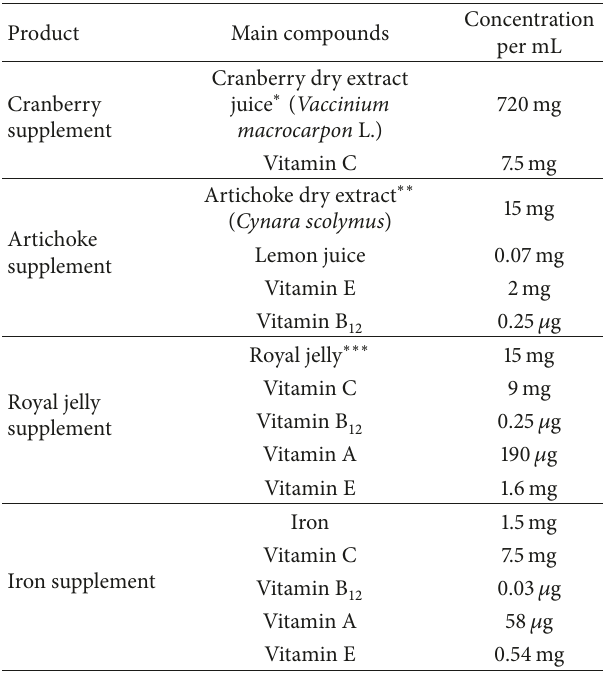
Table 1: Composition of the functional supplements